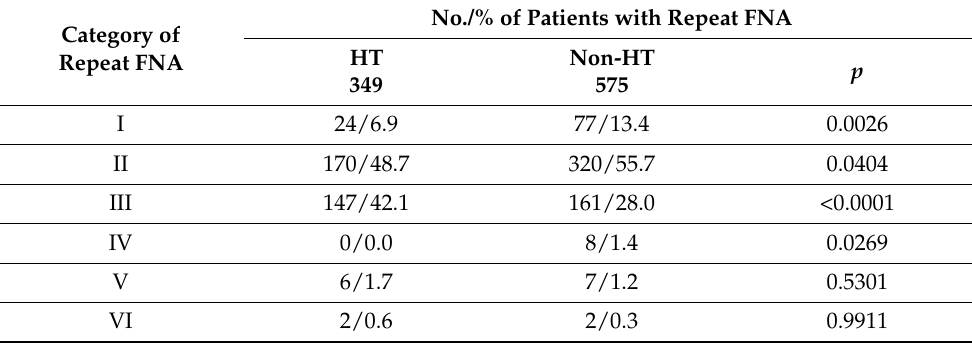
Table 3. Results of repeat FNA in patients from HT and non-HT groups.